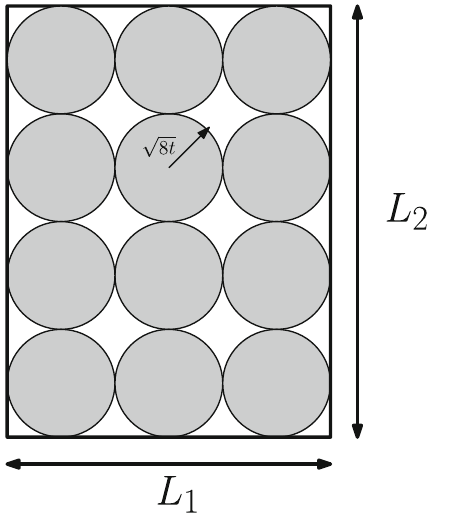
Fig. 9 A simple model to explain the scaling of the variance of the GF coupling